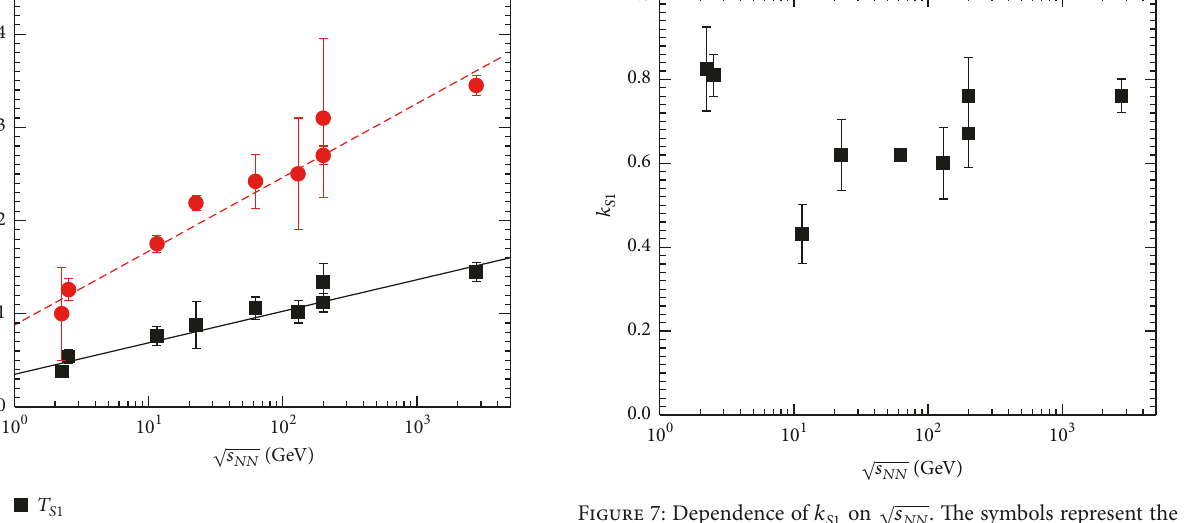
Figure 7: Dependence of 𝑘 𝑆1 on √ 𝑠 𝑁𝑁 . The symbols represent the values of parameter taken from Table 1 and the error bars represent the statistical errors.